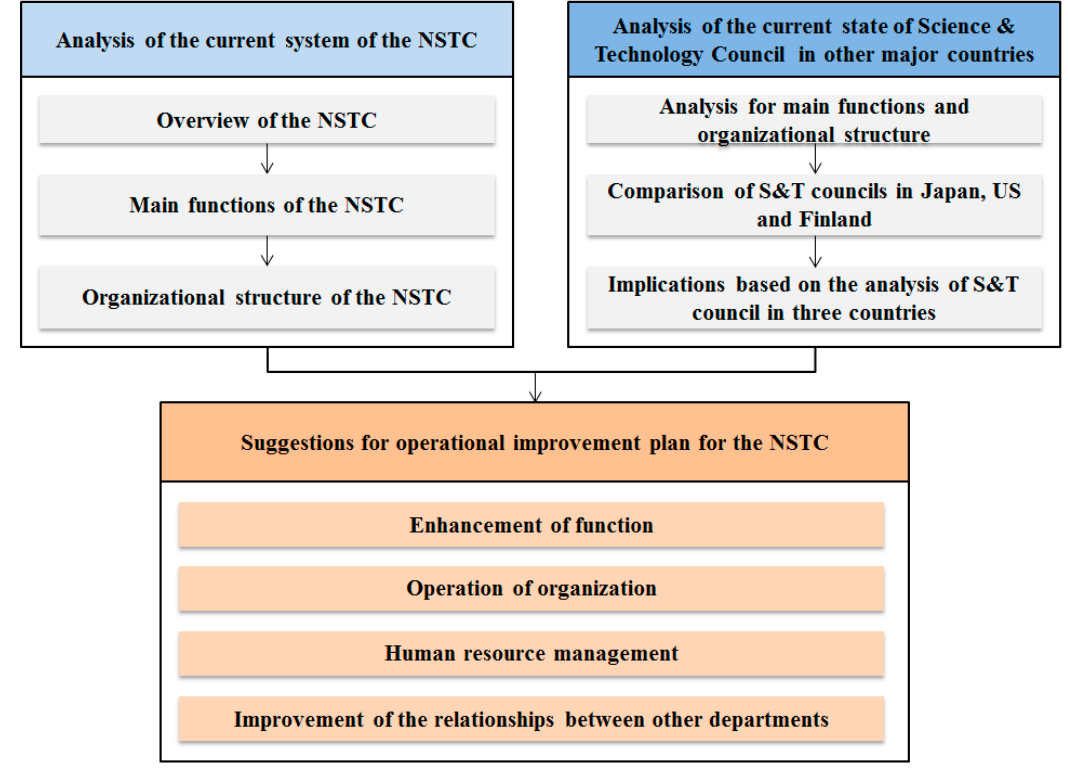
Figure 1. Overall research framework.